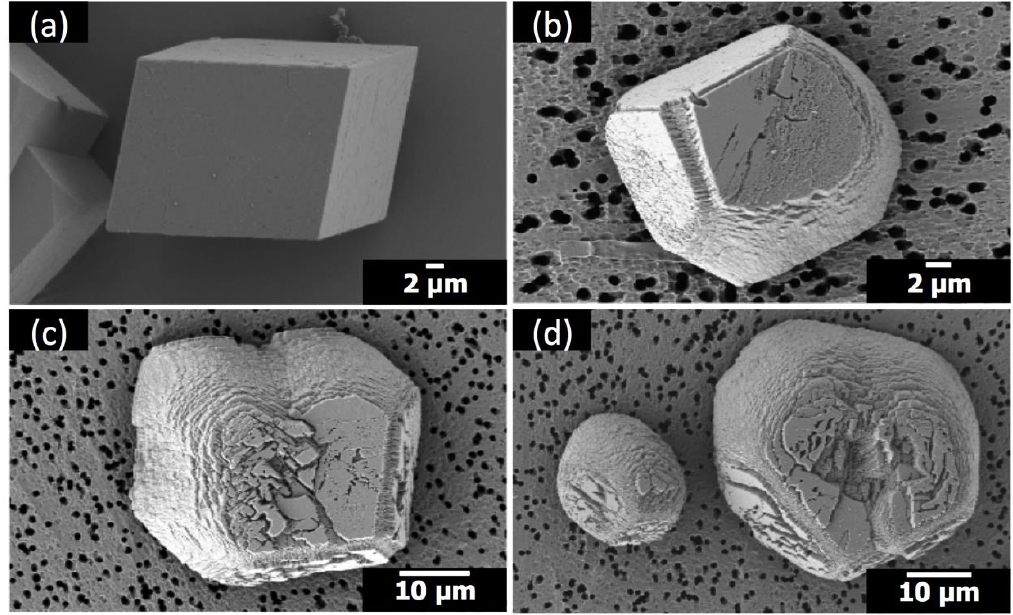
Figure 2. Scanning electron microscopy (SEM) images of the calcite crystals formed with: ( a ) no additives; ( b ) 5 µ M poly(acrylic acid) (PAA) at Sr / Ca = 1:100; ( c ) 5 µ M PAA at Sr / Ca = 1:50; ( d ) 5 µ M PAA at Sr / Ca = 1:25.